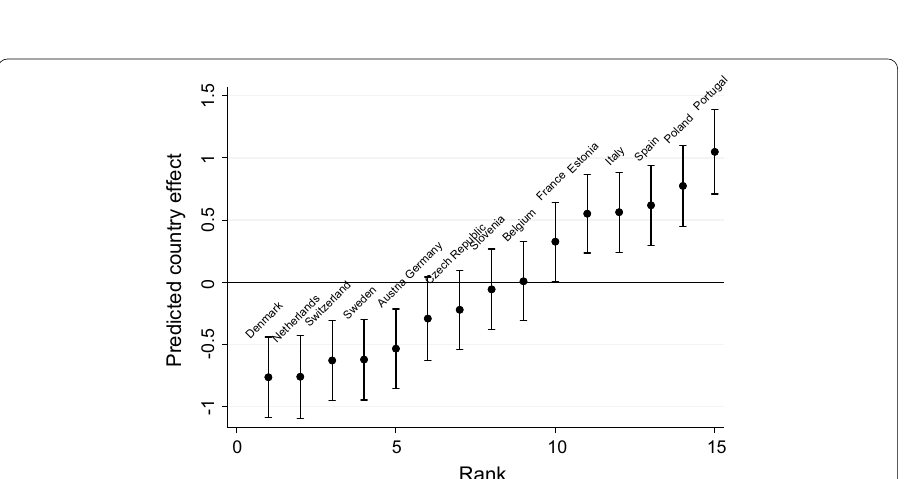
Fig. 2 Predicted country effect on depressive symptoms in the 13 countries, 2012–2018 (Source: Authors’ analysis of the Harmonised SHARE Waves